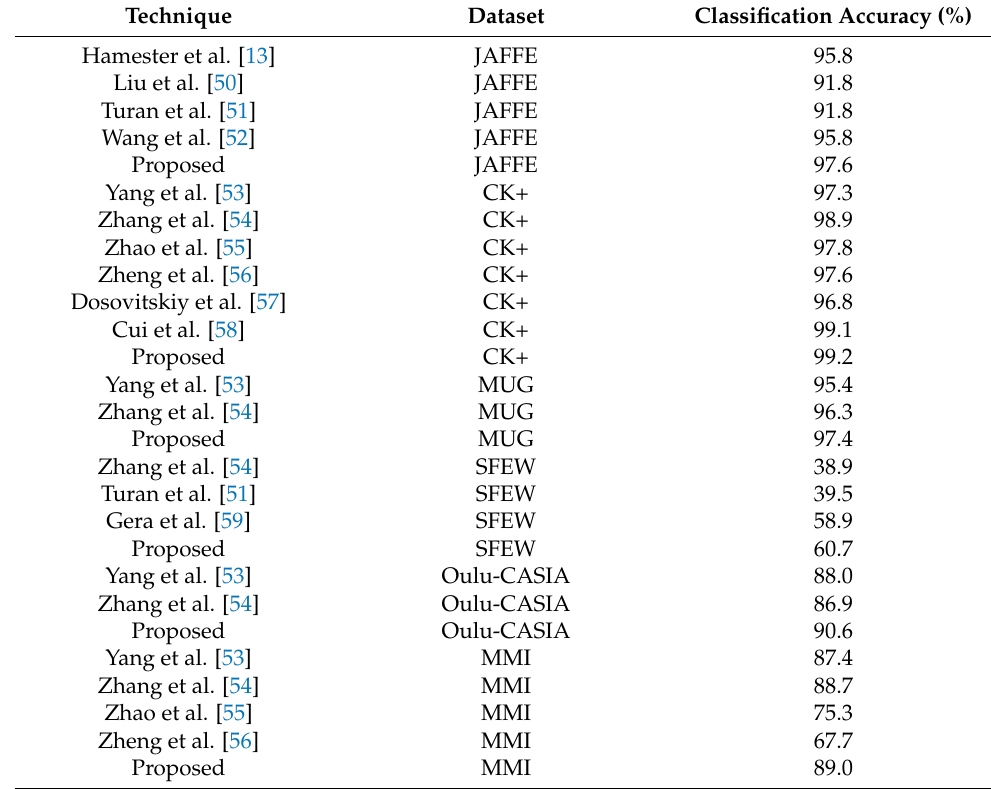
Table 9. Analysis of results with some prevailing